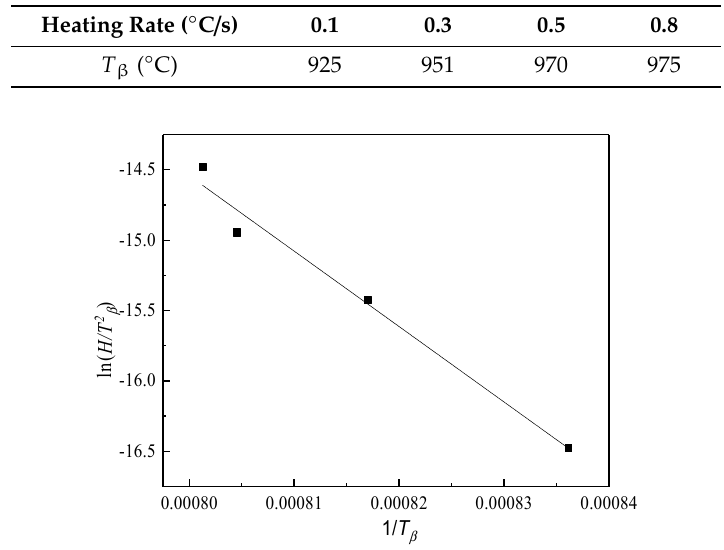
Figure 6. ln( H / T 2 β )-(1 / T β ) linear fitting curve of Ti-6Al-4V during the heating process.